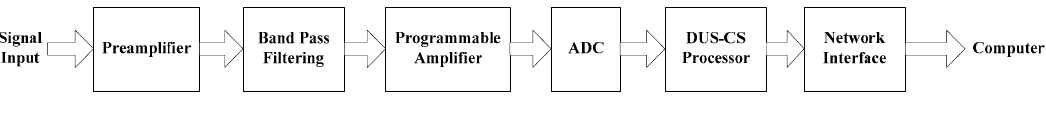
Figure 7. Data acquisition (DAQ) components.